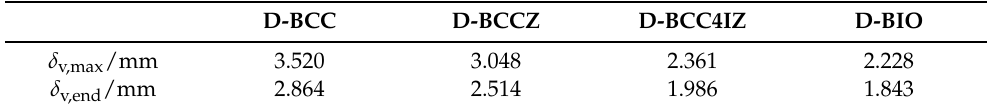
Table 5. The δ v value of four